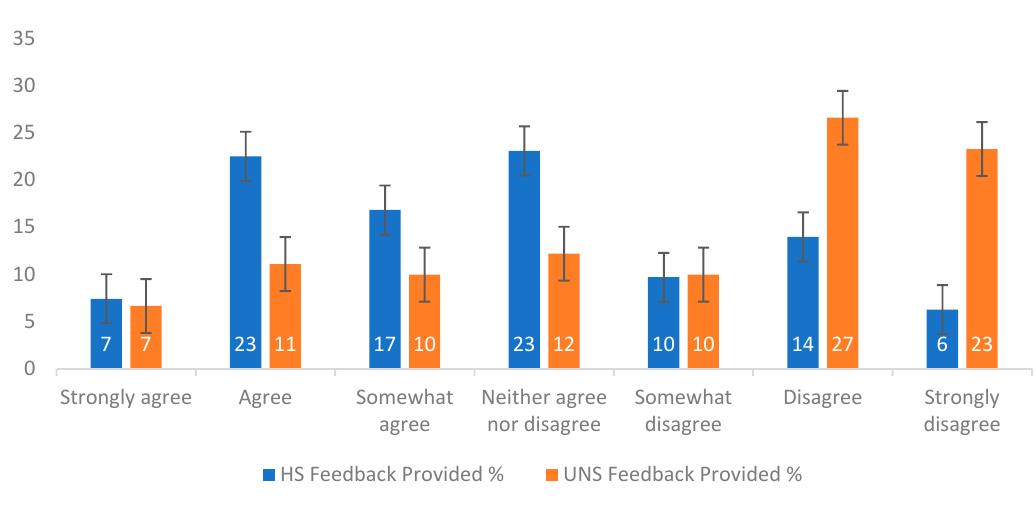
Figure 10. Constructive interview feedback.